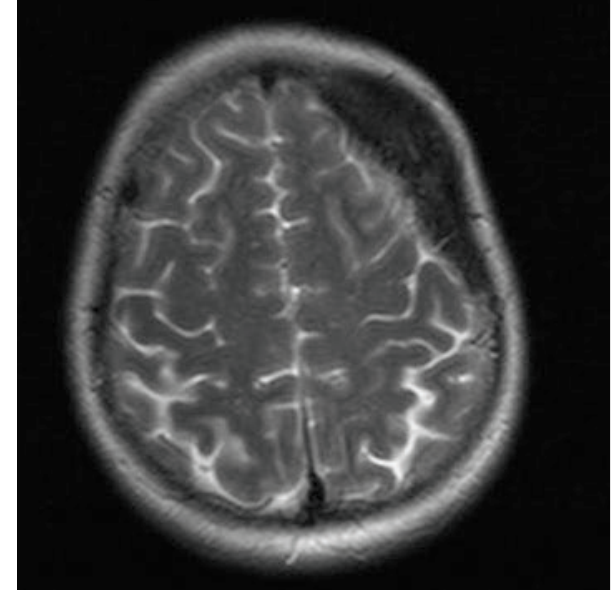
Fig. 3. Axial T2-weighted MR image demonstrates a focal expansile hypo- intense bone lesion in the superior left frontoparietal region of the skull.